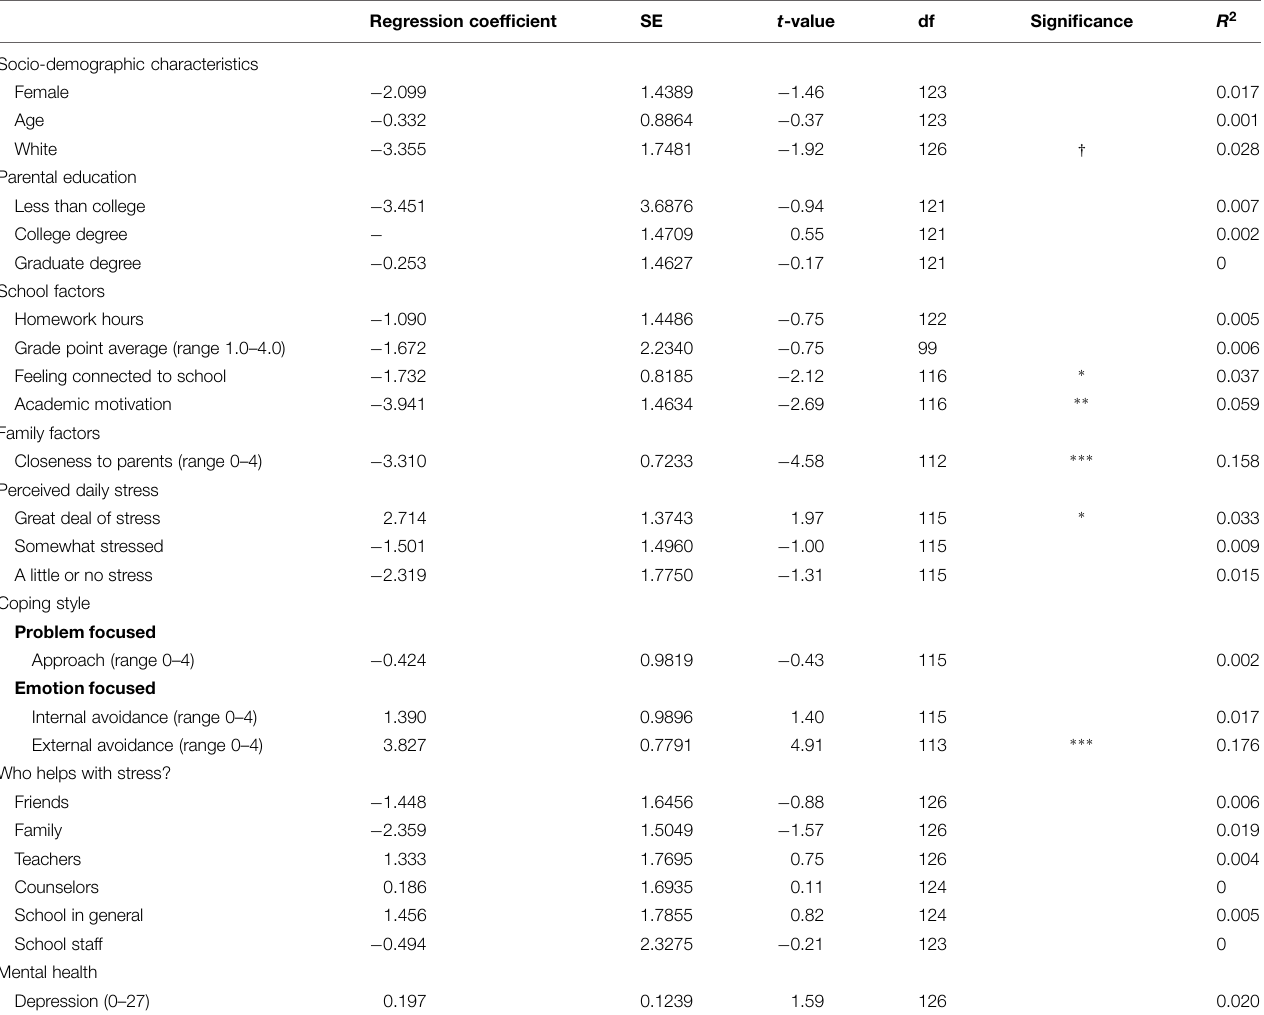
TABLE 2 | Bivariate associations with substance use within the past 30 days. Regression coefficient